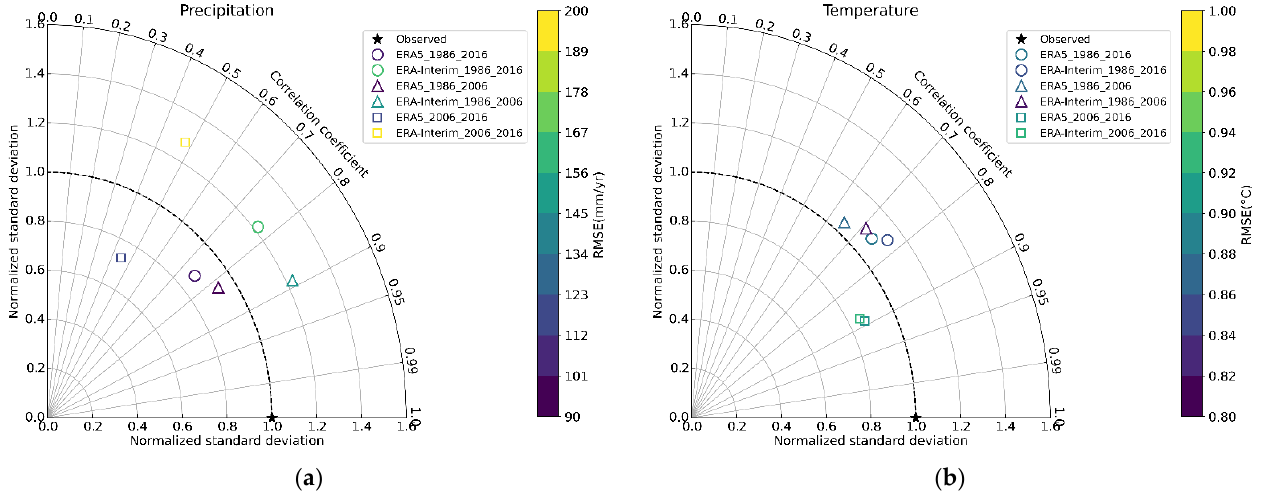
Figure 4. Taylor diagram and RMSE comparing ERA5 and ERA-Interim with the observed data in the Urmia Lake Basin during three periods. ( a ) Mean annual precipitation; ( b ) Mean annual